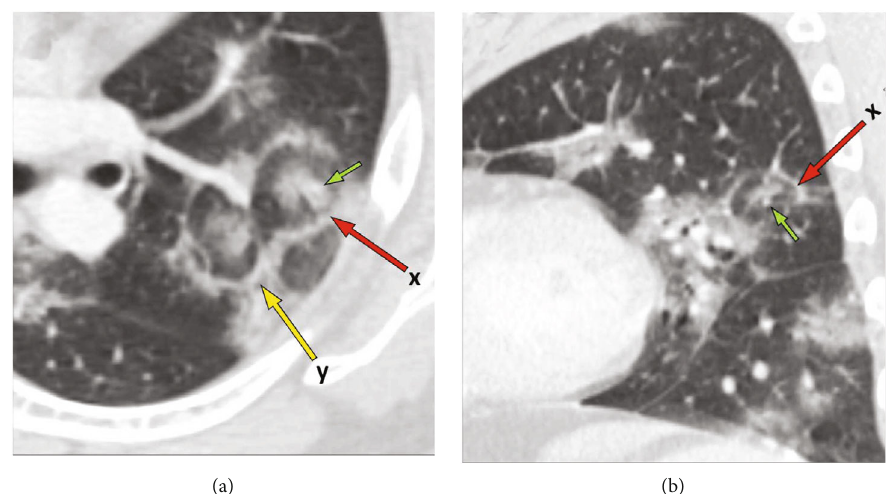
Figure 3: (a) Obliqued axial image demonstrating two adjacent target lesions, labelled “ x ” marked by the red arrow, and “ y ” marked by the yellow arrow. Lesion “ a ” clearly demonstrates a “ central dot ” (small green arrow) which corresponds to a pulmonary artery branch. (b) Oblique sagittal image through lesion “ x ” (red arrow) depicting the “ central dot ” or small pulmonary artery branch (small green